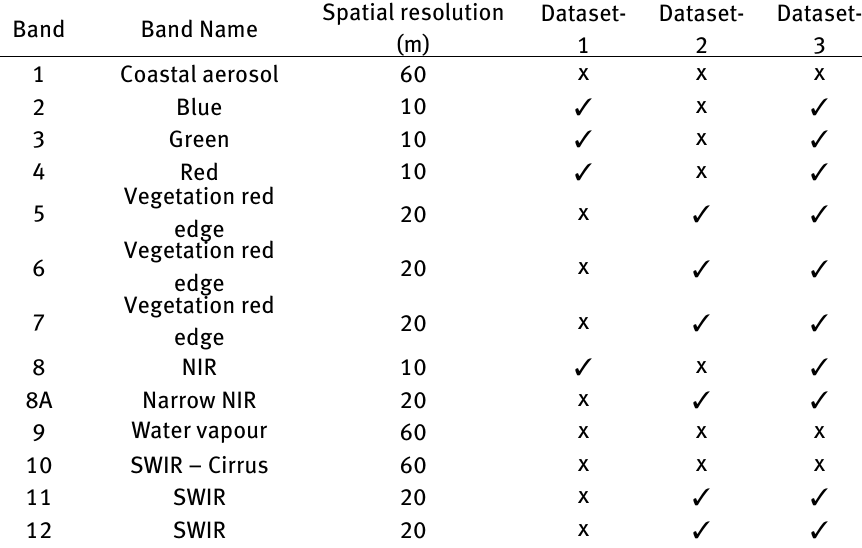
Table 1: Sentinel-2A satellite sensor specifications and details of dataset used in this study.